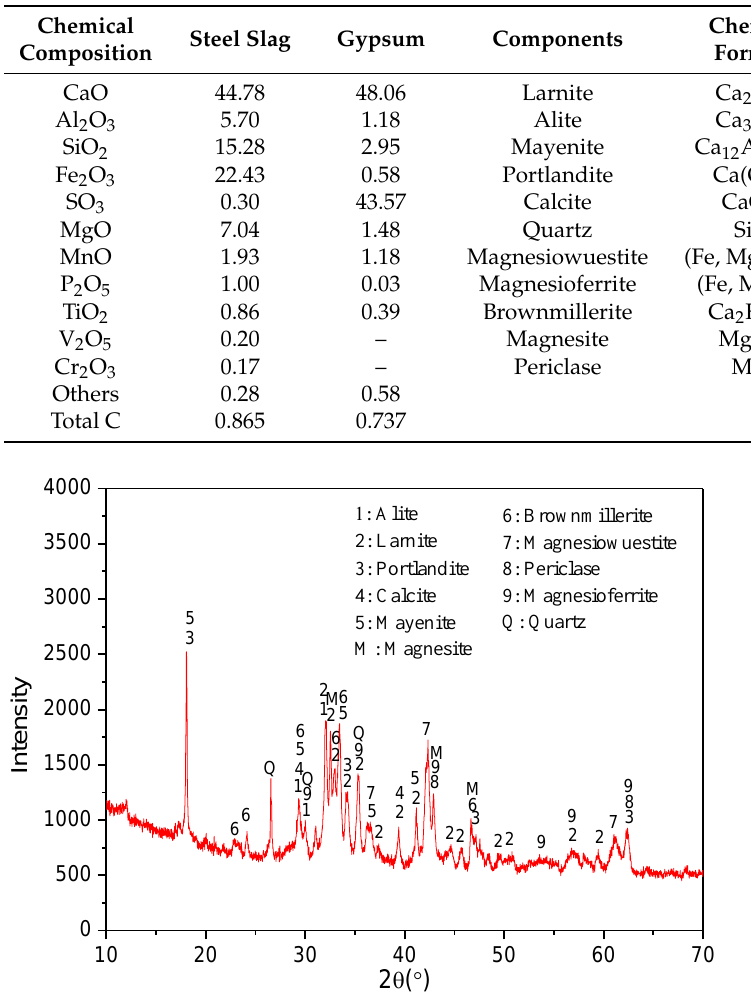
Figure 2. X-ray diffraction pattern for the steel